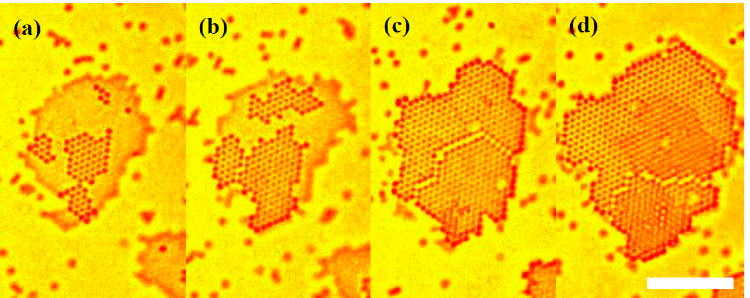
Figure 6. Formation processes of stacking disorders. ( a ) Two-dimensional nucleation on the first triangular layer (90 min. after the injection of a particle dispersion into a growth cell); ( b ) Growth of the nucleated layers (120 min); ( c ) Complete occupation of the second layer and formation of the boundary between two different stacks (200 min); ( d ) Displacement of the boundary accompanied by the growth of the third layers (280 min). Scale bar represents 10 µm.